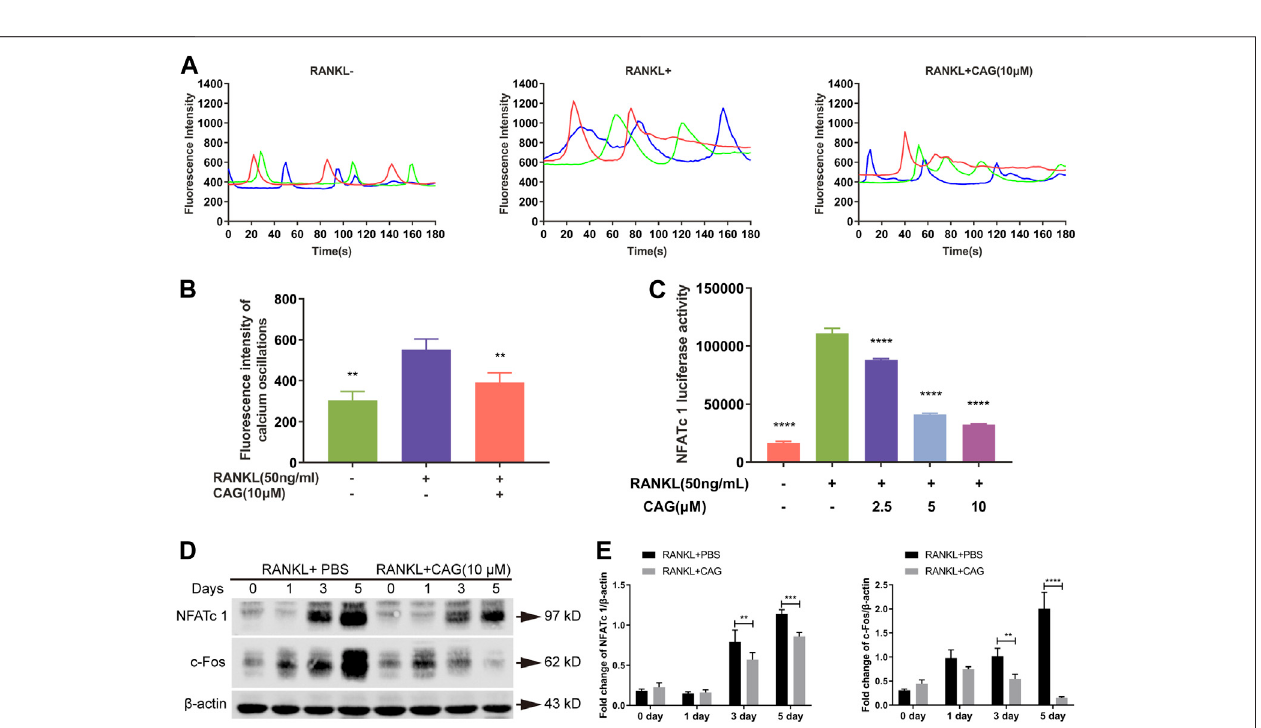
FIGURE 4 | CAG restrains RANKL-induced Ca 2+ /NFATc1 pathway. (A) Fluorescence intensity curves of BMMs loaded with Fluo4-AM calcium probe after being treatedwith10 µMCAGfor48 h. (B) Quantitationof fl uorescenceintensitydisclosedthatCAGadministrationcausedalesseningintheintensityofcalciumoscillationsin BMMs stimulated by RANKL. (C) Luciferase reporter assay in RAW264.7 cells exhibited that 2.5, 5, and 10 µM CAG led to a reduction in NFATc1 activity. (D) Typical western blot images of protein expression in BMMs after being treated with CAG for 1, 3, and 5 days. (E) Quantitative comparison indicated that 3 and 5 days of CAG treatment caused a signi fi cant decrease in the protein expression of c-Fos and NFATc1 in BMMs. Data of all histograms are displayed as mean (SD). n (cid:1) 3. * p < 0.05,** p < 0.01,*** p < 0.001.**** p < 0.0001.RANKL:receptoractivatorofnuclearfactor κ Bligand;CAG:cycloastragenol;NFATc1:nuclearfactorofactivatedTcells1; BMMs: bone marrow monocytes; PBS: phosphate-buffered saline; c-Fos: proto-oncogene